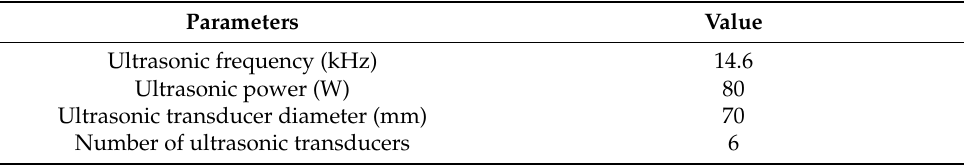
Table 3. Ultrasonic